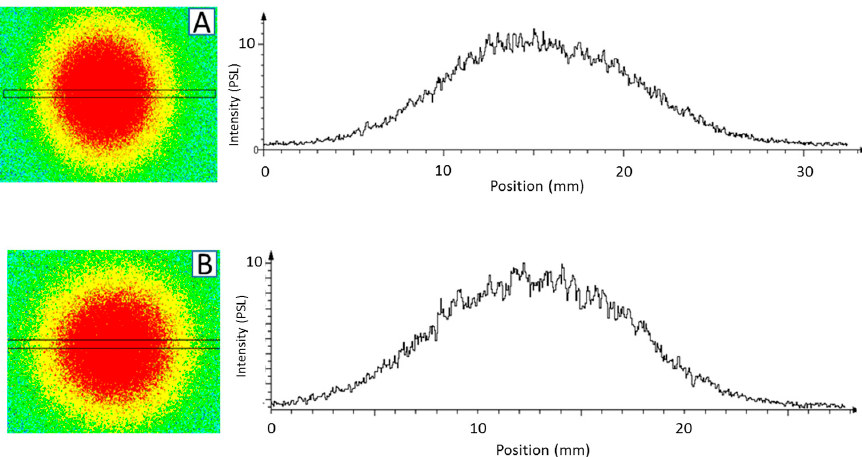
Figure 2. Autoradiographs (left) and profile of radioactivity distributions (right) of the 241 Am alpha sources: ( A ) diamond and ( B ) stainless steel substrates. Electro-precipitation conditions: 0.3 M Na 2 SO 4 pH 3.97 electrolyte + 5.96 Bq 241 Am, current density = 8 mA.cm − 2 , t = 90 min.